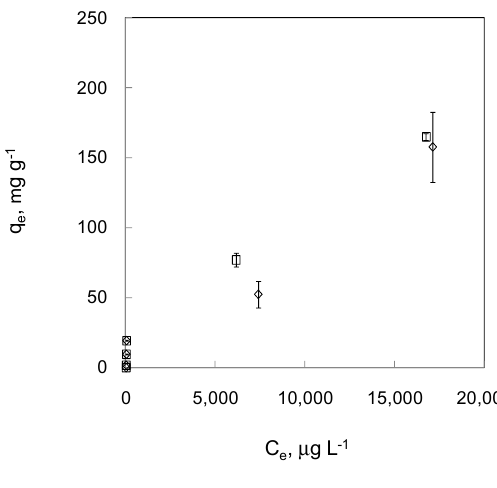
Figure 4. Adsorption of As(III) and As (V) by MNPC under aerobic condition. Empty rhombus represents As (III) and empty square represents As(V). Error bars indicate CI